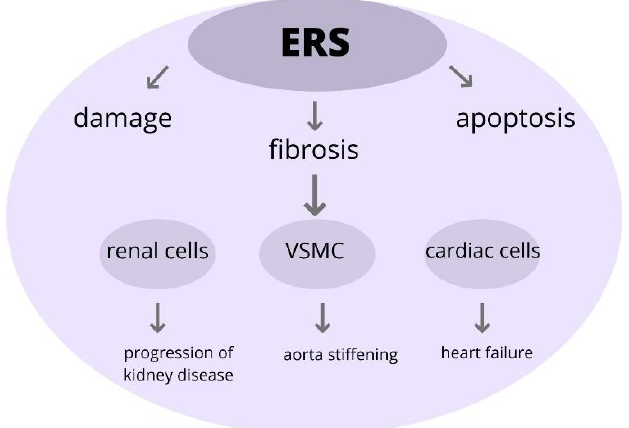
Figure 5. The role of ERS in pathophysiology in TOD. Excessive ERS can trigger pathological changes within the cells, leading to its injury and impairment and eventually participating in the onset of development and progression of organ damage. Abbreviations: ERS-endoplasmic reticulum stress, VSMC-vascular smooth muscle cells, TOD-target organ damage.